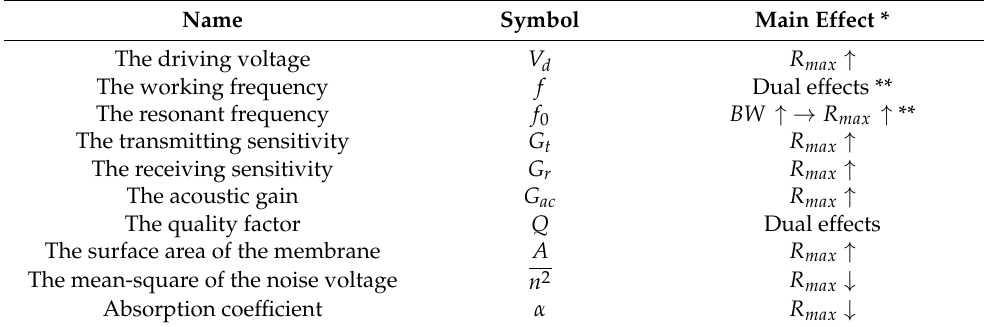
Table 2. Main factors that affect the performance of pMUT